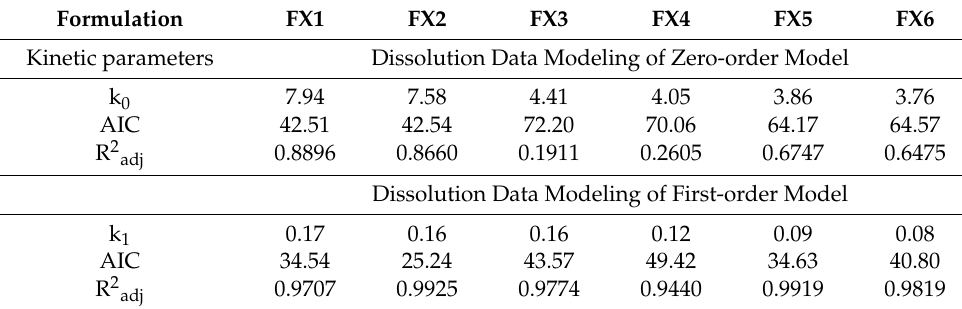
Table 9. Kinetic releasing parameter of the FX from the ODFs. Formulation Kinetic